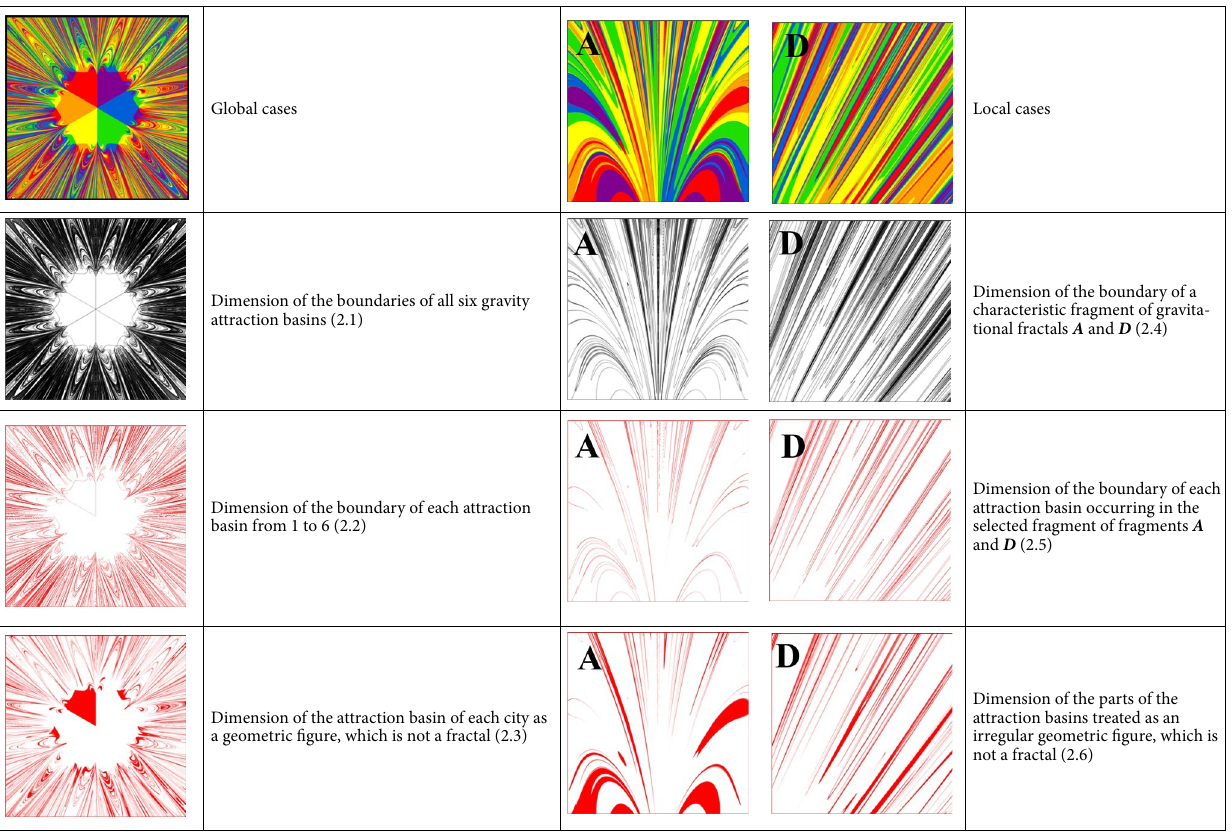
Table 1. Global and local dimensions of gravitational fractals and attraction basins. The numbering 2.1 – 2.6 corresponds to the subdivision of the text presented in the